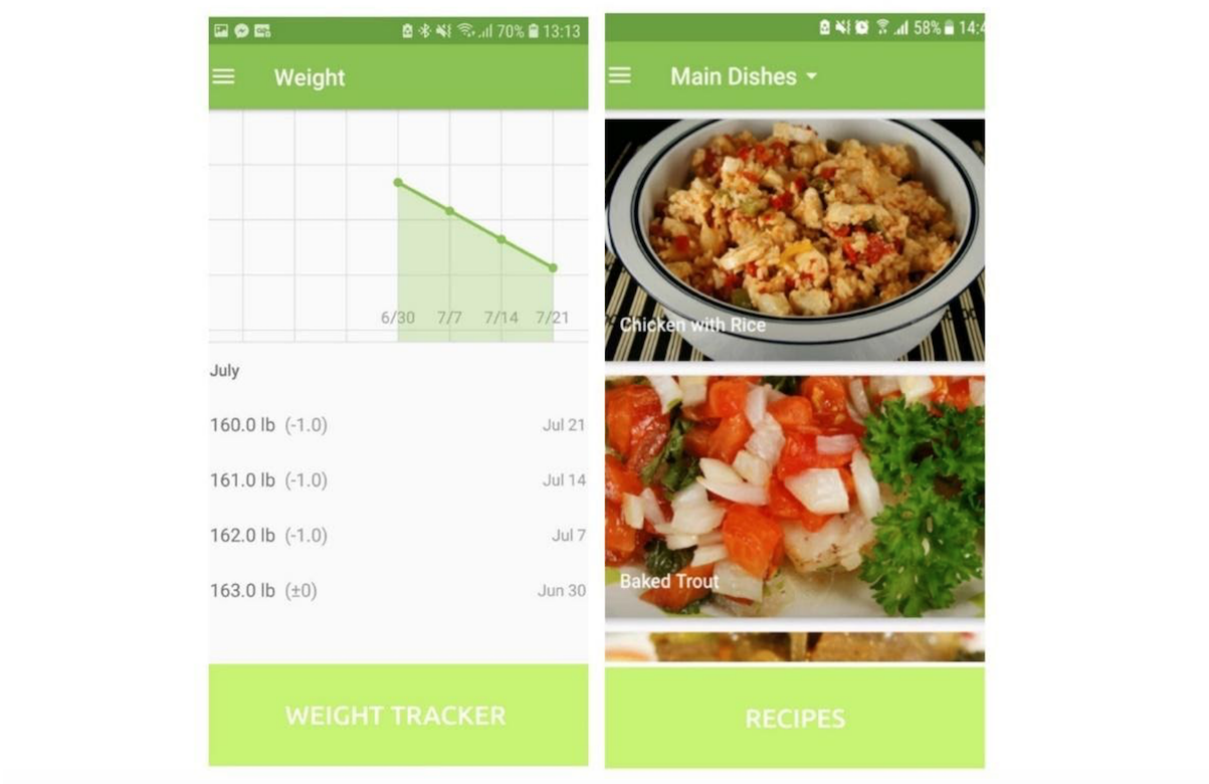
Figure 1. Screenshots from the ¡Hola Bebé, Adiós Diabetes!